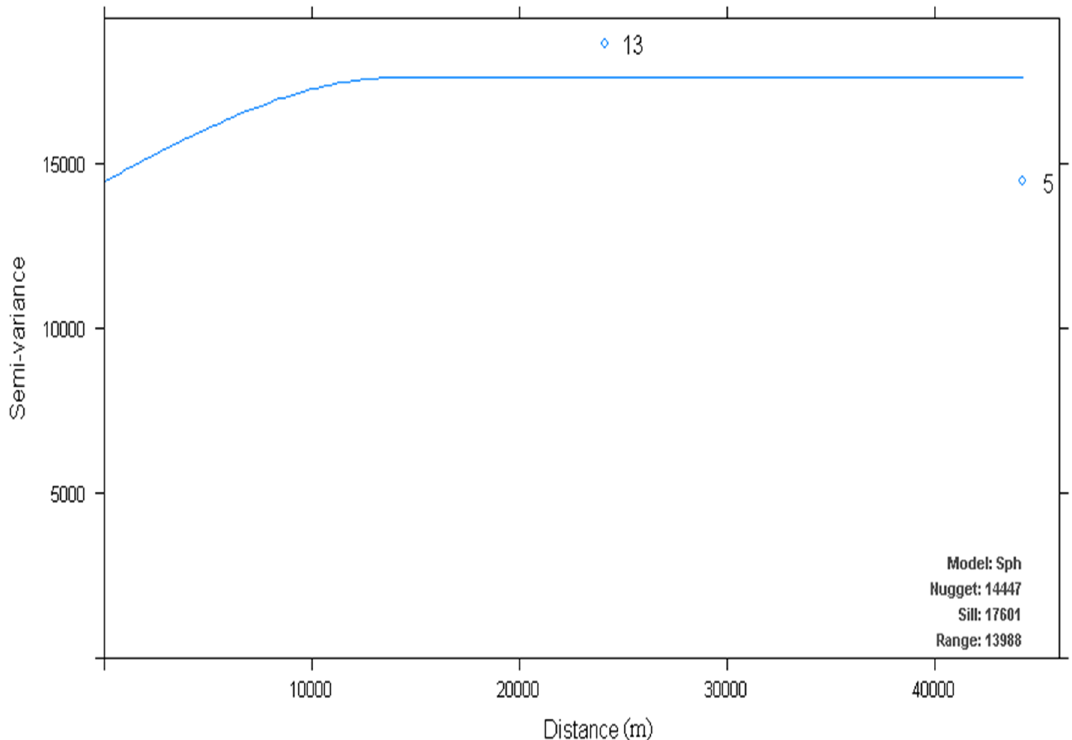
Fig. 9 Empirical variogram fitted with theoretical variogram using spherical variogram model for mean annual PET regression